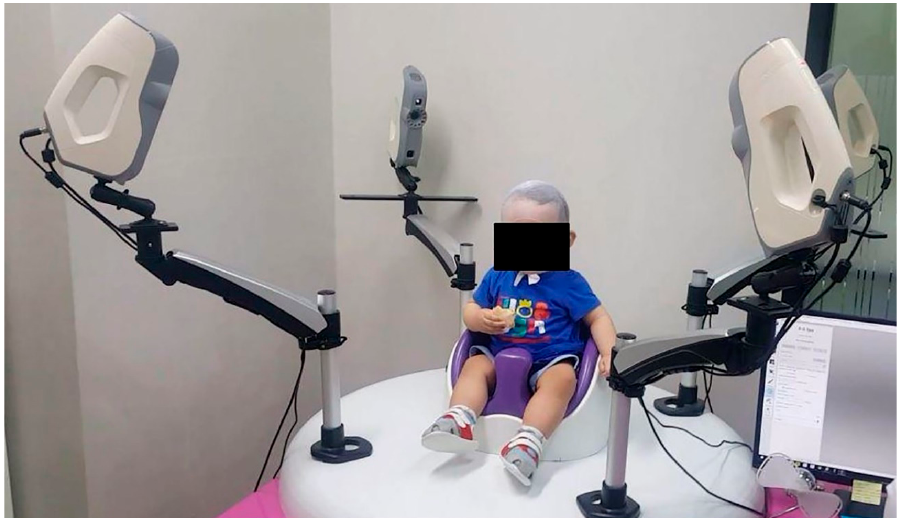
Figure 2. Clinical photograph of the process of scanning for skull deformities. The frequent movement of the infants increased the difficulty of obtaining accurate images. The simultaneous use of four three-dimensional scanners enabled the acquisition of precise images over an imaging duration of only 0.5–0.8 s.